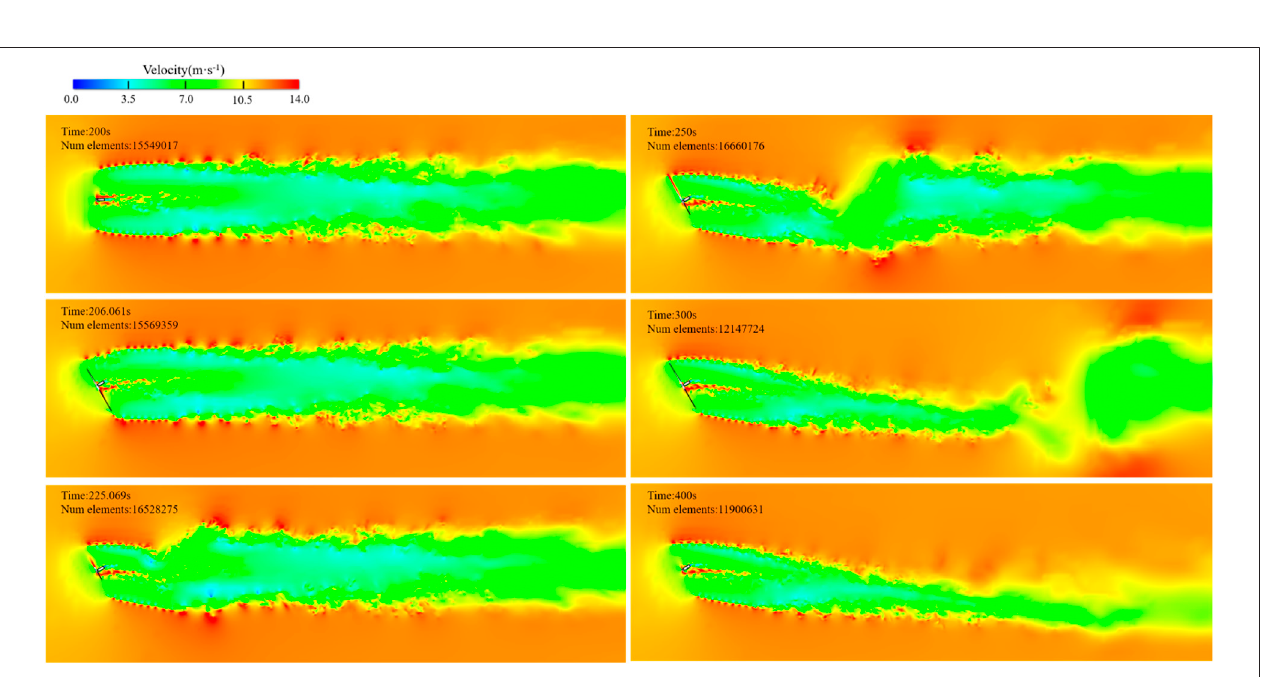
Frontiers in Energy Research |